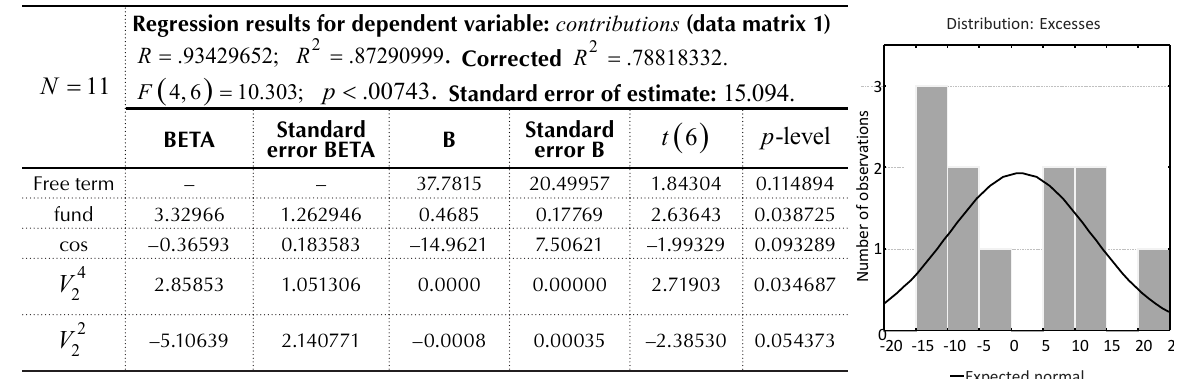
( ) c ( ) x from its volume